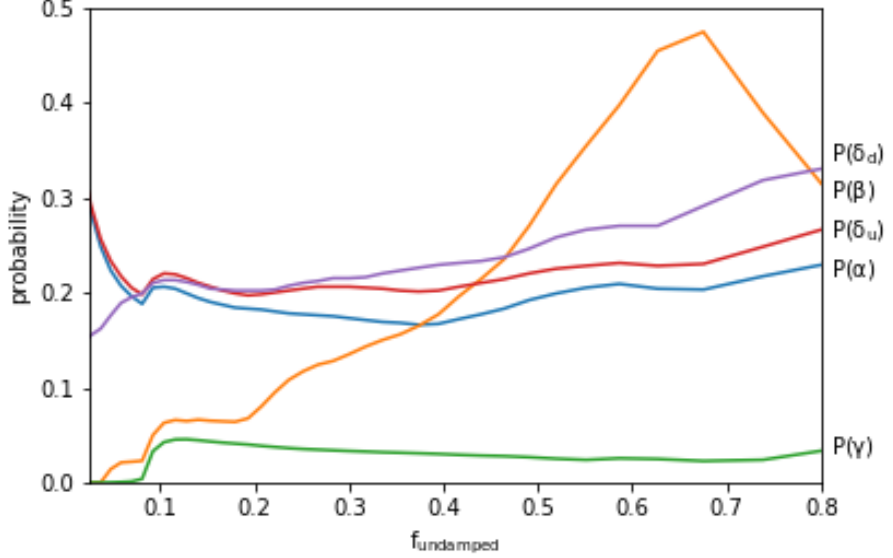
Figure 3. Dependence of the probabilities of observing our constants as a function of the fraction of disrupted planetesimals that enter the inner solar system, as opposed to becoming emplaced in the asteroid